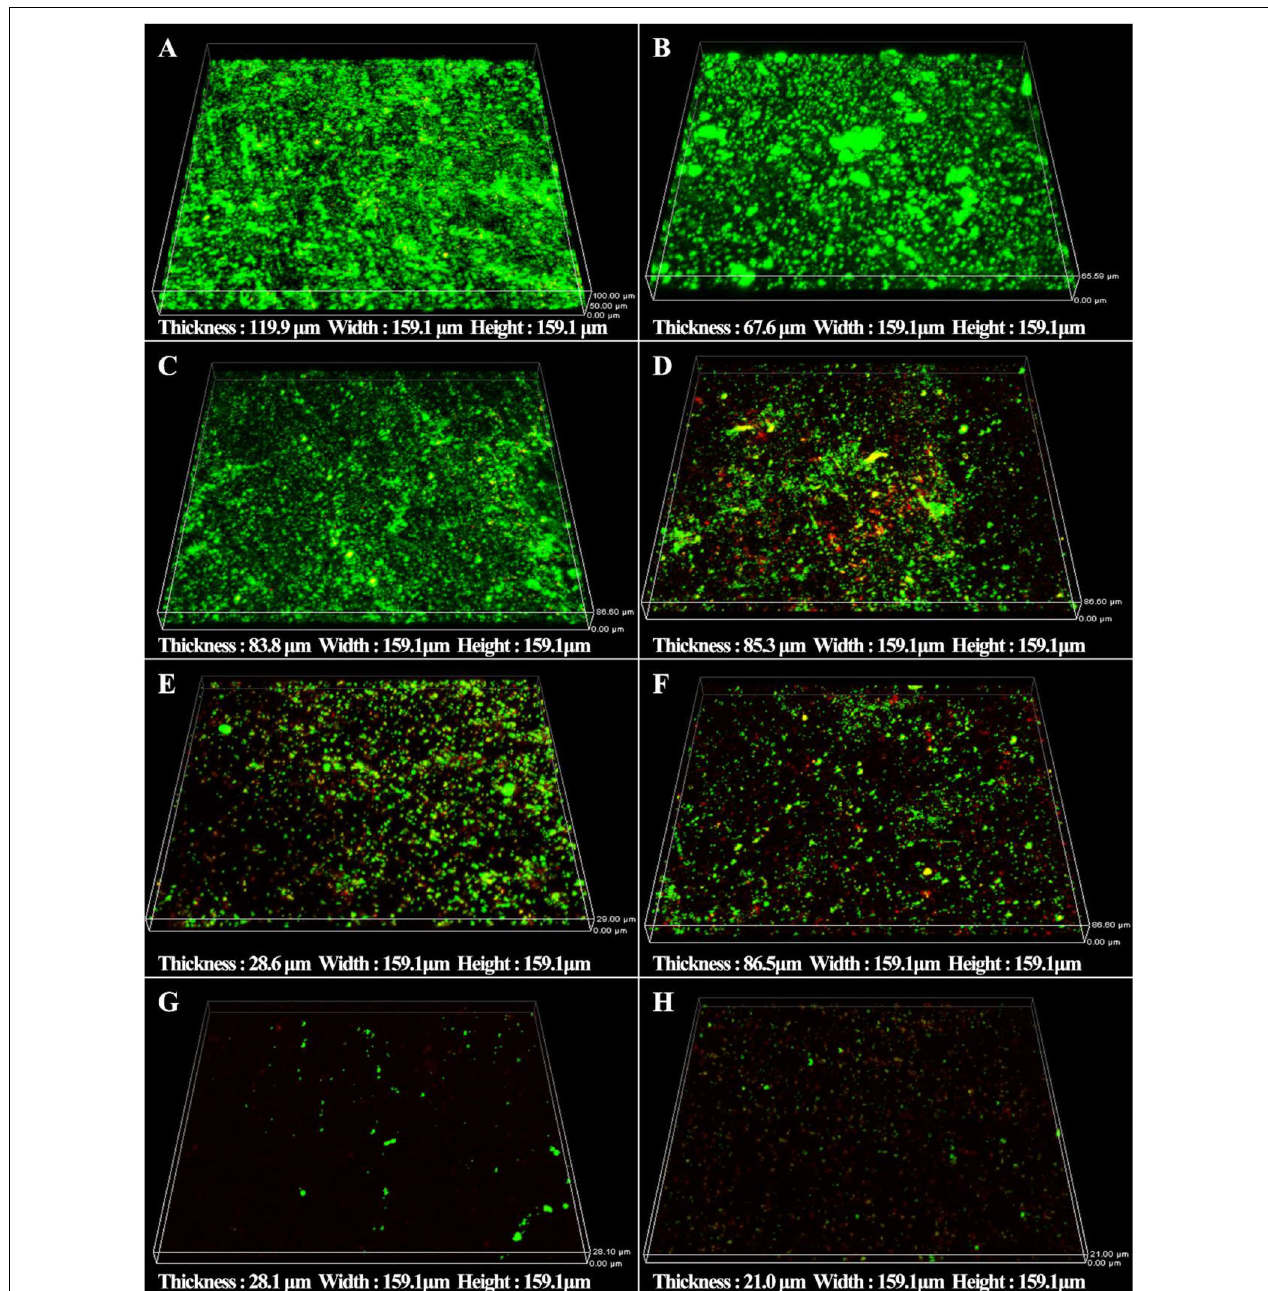
FIGURE 10 | CLSM images of sessile cells after 1-day biofilm removal test: (A) no treatment (control), (B) 1 ppm D -Tyr, (C) 100 ppm D -Met, (D) 5 ppm CMIT/MIT, (E) 5 ppm CMIT/MIT + 1 ppm D -Tyr, (F) 5 ppm CMIT/MIT + 100 ppm D -Met, (G) 5 ppm CMIT/MIT + 1 ppm D -Tyr + 100 ppm D -Met, and (H) 25 ppm